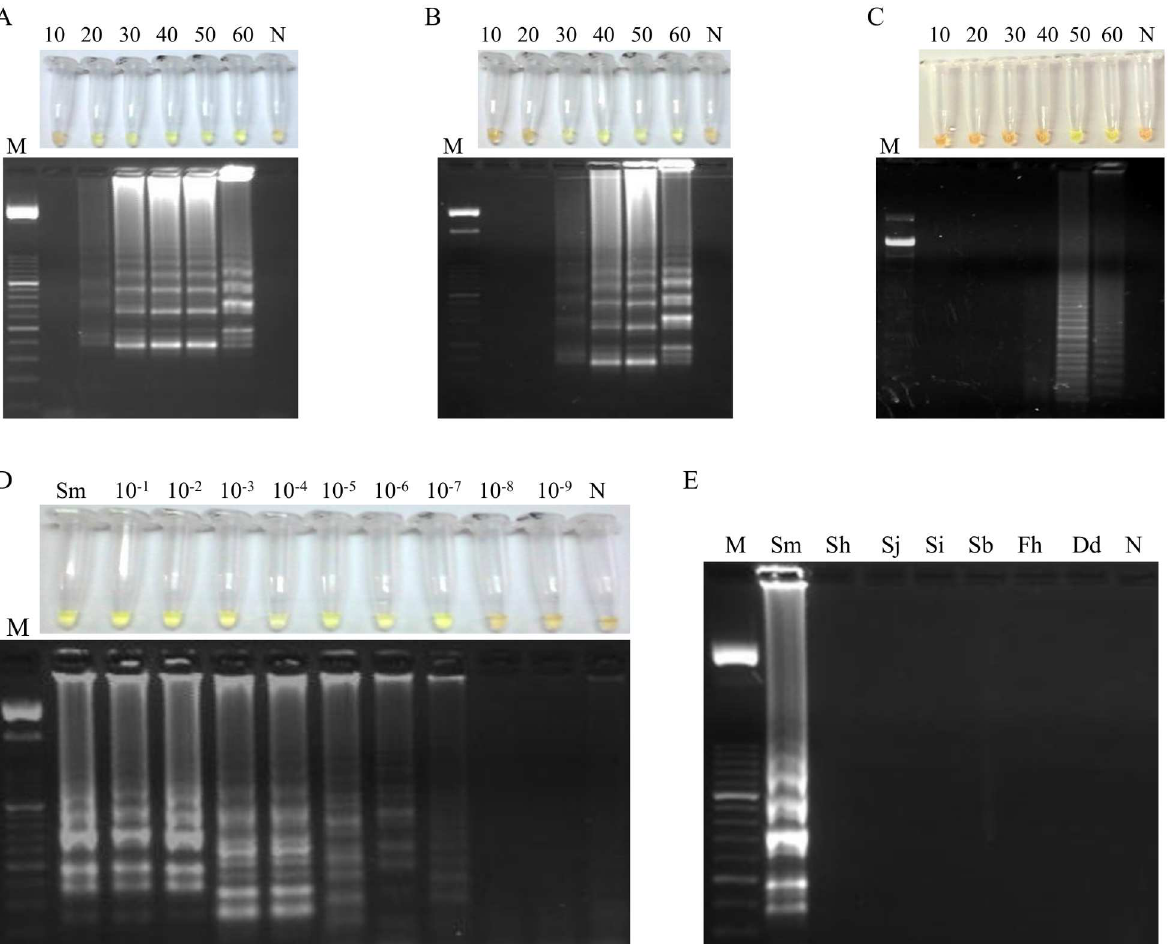
Fig 4. Setting up LAMP assay. LAMP amplification results using (A) 1 ng, (B) 1 pg and (C) 1 fg of S . mansoni DNA obtained at different incubationtimes (10, 20, 30, 40, 50 and 60 min) tested in a heatingblock by the additionof SYBR Green I (top) or by visualizationon agarosegel (bottom). Lanes M, 50 bp DNA ladder(Molecular weight marker XIII, Roche); lanes N: negativecontrol (no DNA template). (D) Sensitivity assessment performed with LAMP at 63˚C for 50 min using serial dilutions of S . mansoni genomicDNA. Lane M: 50 bp DNA ladder(Molecularweight marker XIII, Roche); lane Sm: genomicDNA from S . mansoni (1 ng); lanes 10 − 1 –10 − 9 : 10-fold serially dilutions; lane N: negativecontrol (no DNA template). (E) Specificityof the LAMP assay for S . mansoni .A ladderof multiplebandsof different sizes could be only observedin S . mansoni DNA sample. Lane M, 50 bp DNA ladder(Molecularweight marker XIII, Roche); lanes Sm, Sh, Sj, Si, Sb, Fh and Dd, S . mansoni , S . haematobium , S . japonicum , S . intercalatum , S . bovis , Fasciola hepatica and Dicrocoelium dendriticum DNA samples(1 ng/each), respectively; lane N, negativecontrol (no DNA template).